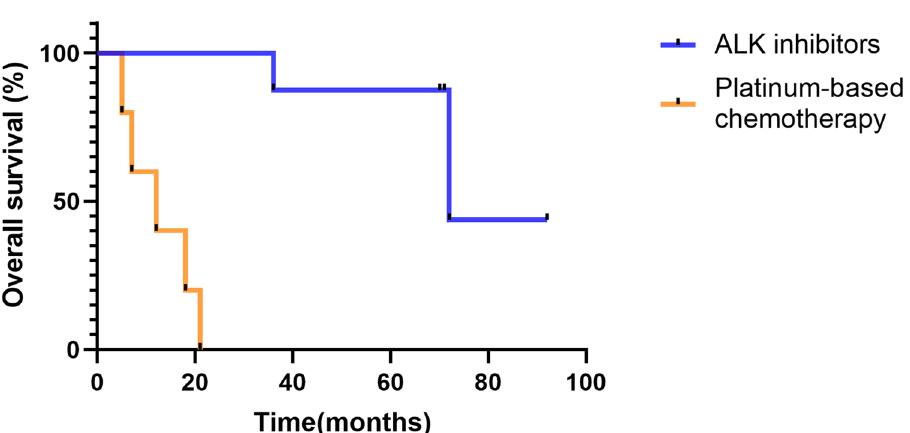
Figure 2. Overall survival (OS) of patients with ALK-positive lung cancer receiving ALK inhibitors or platinum-based